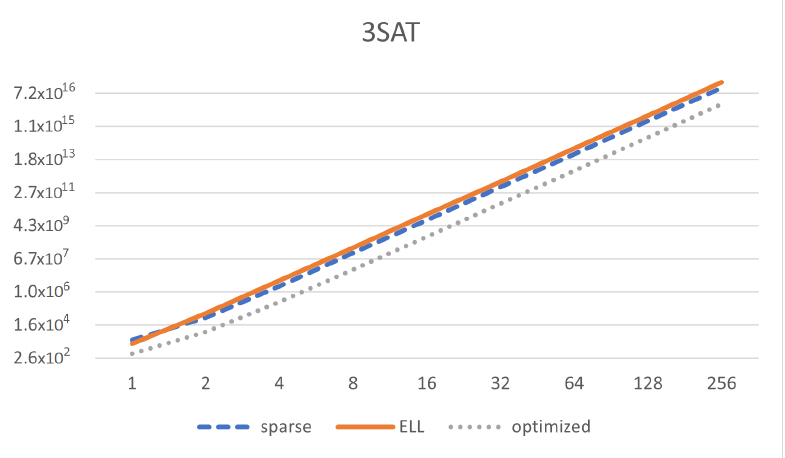
Figure 10. Memory size of the matrix representation (Y-axis in log scale) depending on the number of variables in the SAT formula (1 ≤ n ≤ 256, X-axis in log scale) for the model of 3SAT, using sparse, ELL, and optimized